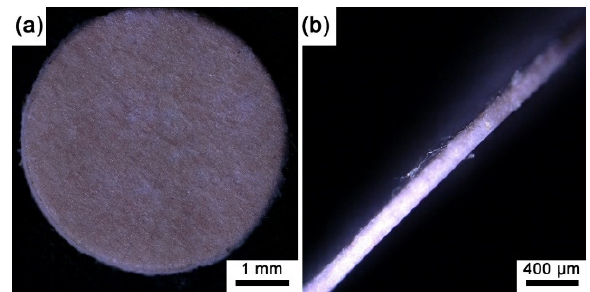
Figure 3. ( a ) The optical image of the sensing film (SF-EC) with a diameter of 5 mm; ( b ) side view of the sensing film (SF-EC) with a thickness of 160 μ m.